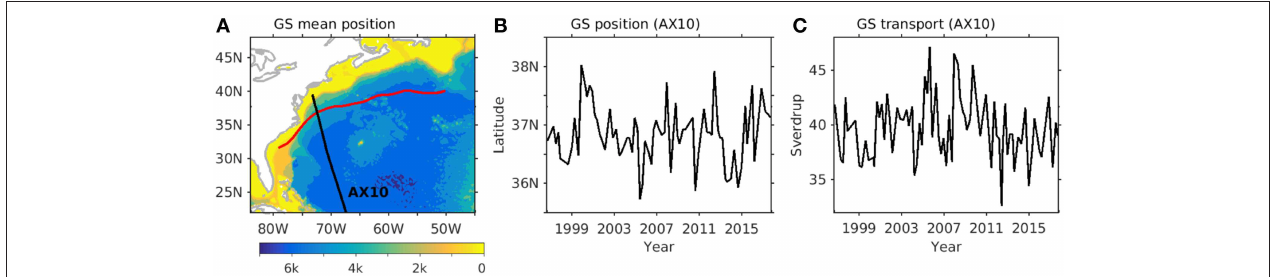
FIGURE 3 | (A) Time-mean Gulf Stream position from satellite altimetry (red) and the location of the XBT AX10 transect (black). (B) Gulf Stream position from AX10 in degree latitude. (C) Gulf Stream transport in the upper 800m water column from AX10 (referenced to 800m); units are Sverdrups (10 6 m 3 s − 1 ). The background color shows the bottom depth.